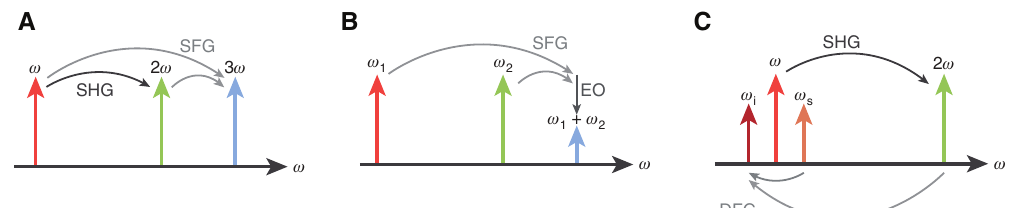
Figure 22: Cascaded nonlinear processes based on integrated LNOI photonics. (A) Cascading SHG and SFG processes generates a third harmonic wave. (B) Cascading SFG and electro-optic processes enables modulating the sum-frequency wave electrically. (C) Cascading SHG and DFG processes generates a signal wave and an idler wave around the fundamental wave